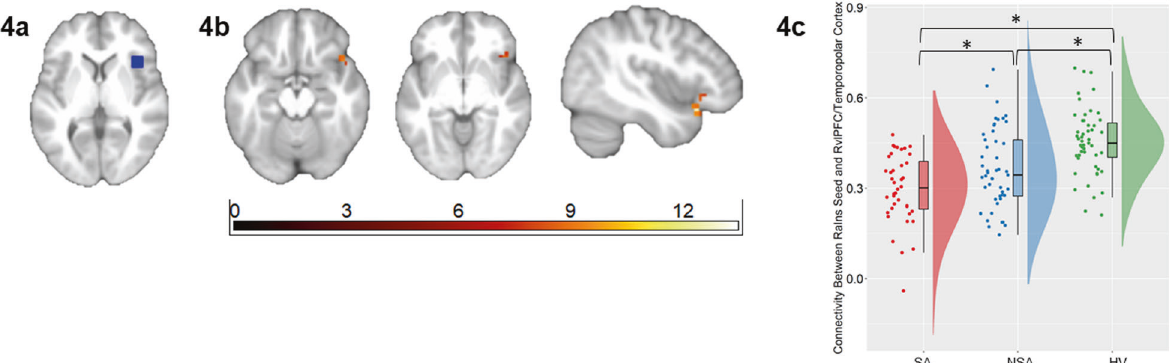
Fig. 4 Alterations in functional connectivity from the right anterior insula associated with suicide attempts in bipolar disorder. The axial and sagittal images show regions of differences in functional connectivity from the right anterior insula (RaIns, a region of the olfactocentric paralimbic cortex (OPC)) seed region (Fig. 4a) to the right ventrolateral prefrontal cortex (RvlPFC) and right temporopolar regions of the OPC (Fig. 4b) using an ANCOVA analysis comparing individuals with bipolar disorder with history of suicide attempts (SA group; n = 40), individuals with bipolar disorder without suicide attempts (NSA group; n = 49) and healthy volunteers (HV; n = 51) ( p < 0.05, corrected for family-wise error). Left of fi gure denotes left side of brain. The color bar represents the range of F values. The raincloud plot (Fig. 4c) of distribution of extracted z-values from the RaIns-RvlPFC/temporopolar cluster show the group differences resulted from lower connectivity in the SA group compared to the NSA and HV groups ( p < 0.05, corrected for 3 pair-wise group comparisons).